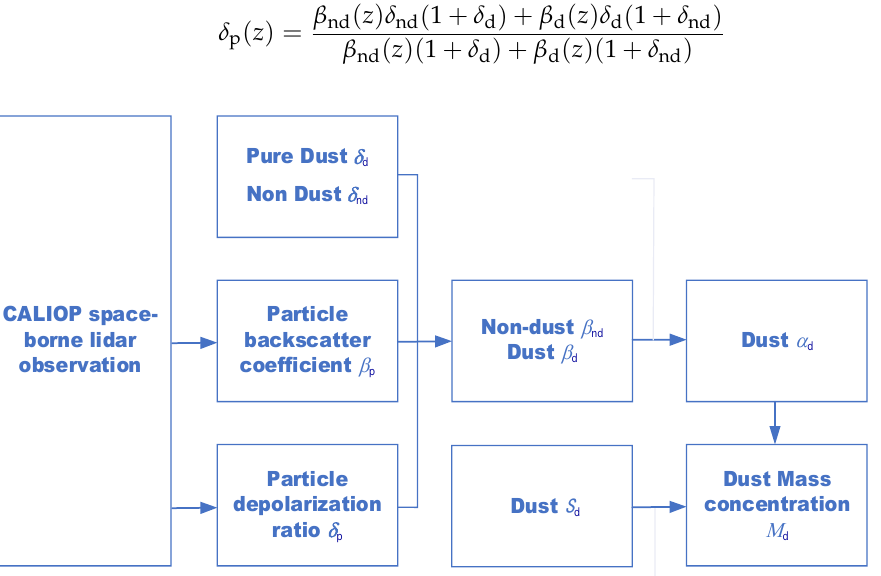
Figure 2. Flowchart of the dust extinction coefficient 𝛼 p and the mass concentration of dust 𝑀 d using the POLIPHON method.